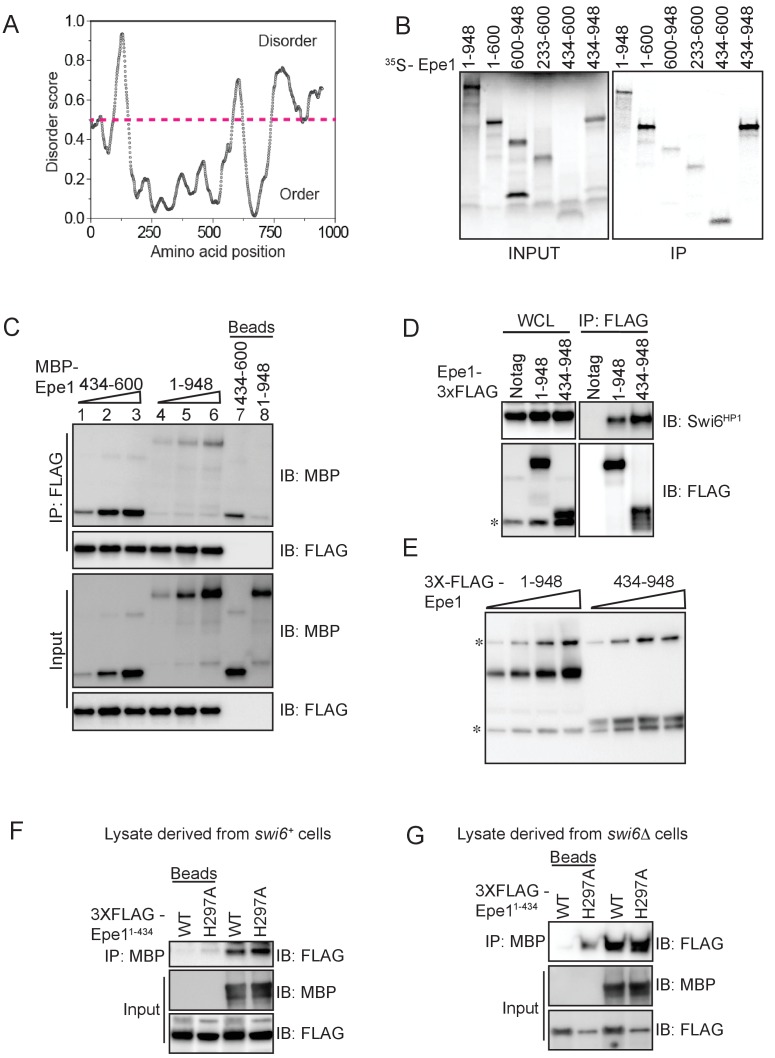
In vitro assays to map the site of interaction between Epe1 and Swi6HP1.(A) Using a computational disorder prediction program (http://www.pondr.com, VSL2) and a user-specified cut-off, we defined ordered and disordered regions within Epe1. The JmjC domain spans 233-434 amino acids and emerges as one of two ordered domains in Epe1. The second ordered region within the C-terminus of Epe1 has no structural similarity to existing proteins. (B) An in vitro translation assay using rabbit reticulocyte lysates to generate S35 labeled fragments of Epe1. Swi6HP1 was immobilized on beads and incubated with IVT extracts. Two Epe1 regions ranging from 1-600 amino acids and 434-948 amino acids emerge as the primary interacting fragments. (C) Increasing amounts of MBP-Epe1434-600 protein is added while maintaining a fixed amount of 3X-FLAG- Swi6HP1on beads. MBP-Epe1434-600 exhibits an increase in binding to Swi6HP1 compared to full-length Epe1. (D) Western blots of co-immunoprecipitation experiments to detect an interaction between Epe1434-948 and Swi6HP1. (E) Western blots of whole-cell extracts of cells expressing full-length Epe1 or Epe1434-948 fused to a FLAG epitope tag. The Epe1434-948 protein is expressed at levels that are at least 4-5 fold lower than full-length Epe1 which in part might explain its limited efficacy in cells. The asterisk in the figure denotes the non-specific FLAG antibody band. (F) A recombinant C-terminal fragment of Epe1, MBP-Epe1434-948 was incubated with fission yeast cell extracts expressing the N-terminal half of the protein, FLAG-Epe1-N (1-434 amino acids) or FLAG-Epe1-N (1-434 amino acids) H297A. Extracts were derived from swi6+ (G) A recombinant C-terminal fragment of Epe1, MBP-Epe1434-948 was incubated with fission yeast cell extracts expressing the N-terminal half of the protein, FLAG-Epe1-N (1-434 amino acids) or FLAG-Epe1-N (1-434 amino acids) H297A. Extracts were derived from swi6Δ cells.